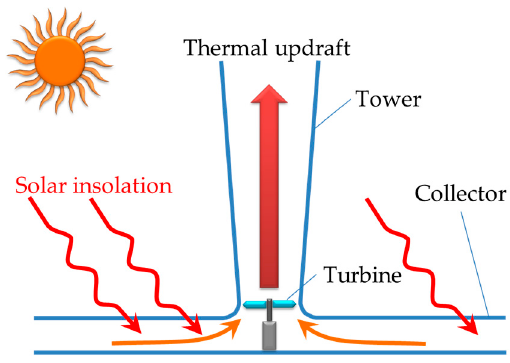
Figure 1. Power generation mechanism of a solar tower.